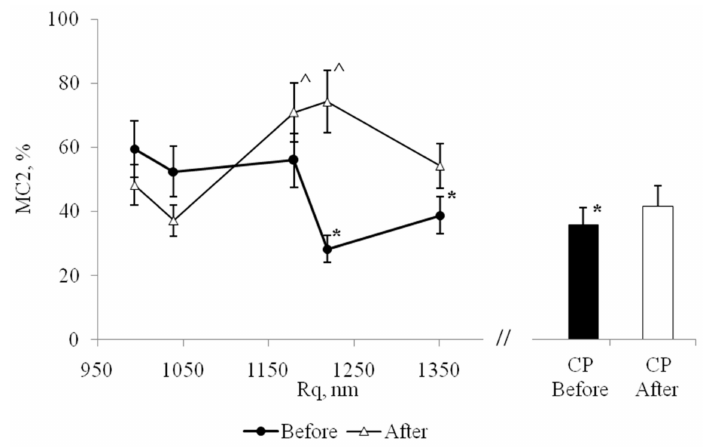
Figure 8. The dependence of the number of elongated MPhs (MC2) on the value of Rq, before (Before) and after (After) stenting. CP—cultural plastic. *—significant di ff erence from the value for the first point, Rq min = 993 nm, option before stenting, ( p < 0,05). ˆ—significant di ff erence from the value